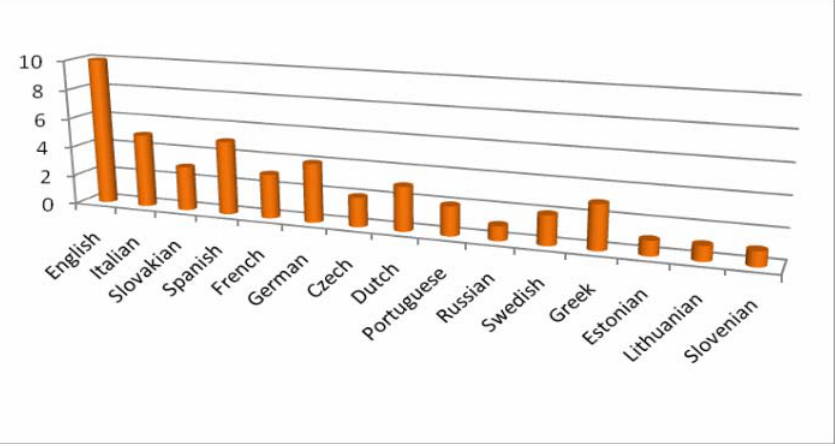
Figure 2: Languages used in the pilot trials (MOMENTUM White Paper, June